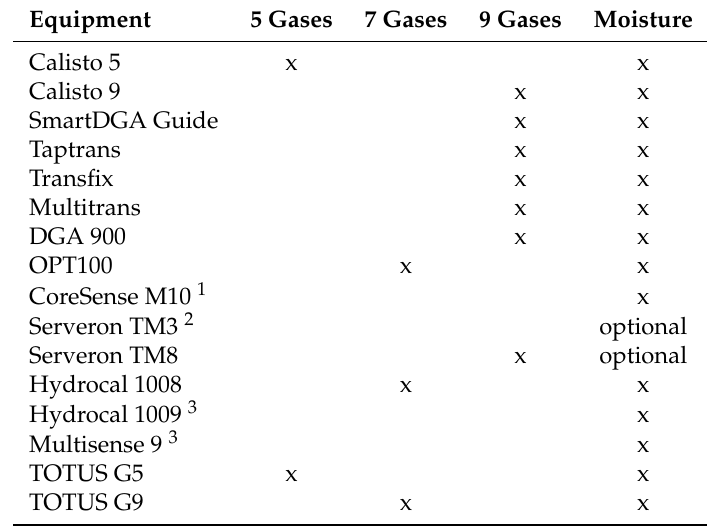
Table 10. Parameters measured by fault diagnosis monitors (as indicated by manufacturers). Equipment 5